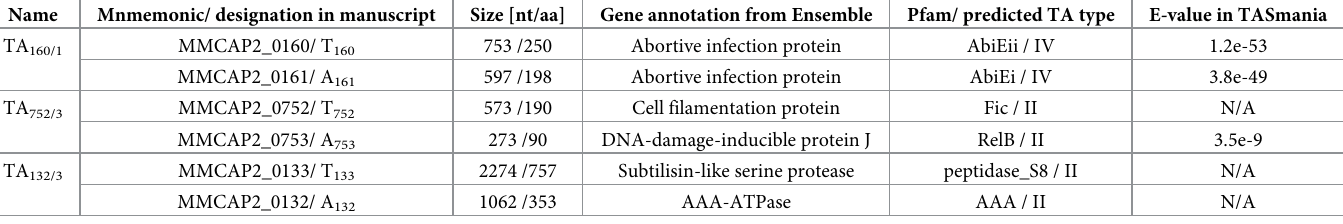
Table 1. Candidate toxins and antitoxins of M . mycoides subsp. capri GM12 investigated in this study. The top two candidate TA systems were identified in silico by using the TASmania